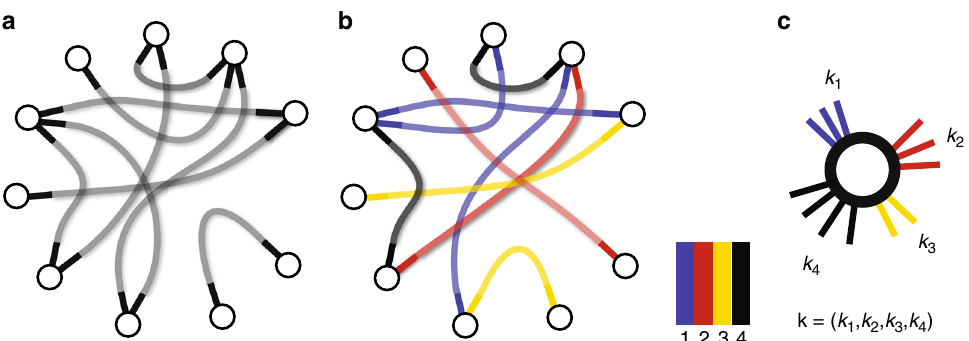
Fig. 1 The concept of edge-coloured con fi guration model. a The con fi guration model with unicoloured edges 19 : any con fi guration of edges that matches all pairs of half-edges produces a valid network. b Edge-coloured con fi guration model: valid con fi gurations have to link matching pairs of colours. In this example, N = 4 colours are used as indicated by the colour palette, although the methodology of this paper allows N to be an arbitrary number. c The con fi guration of a randomly chosen node is a vector of